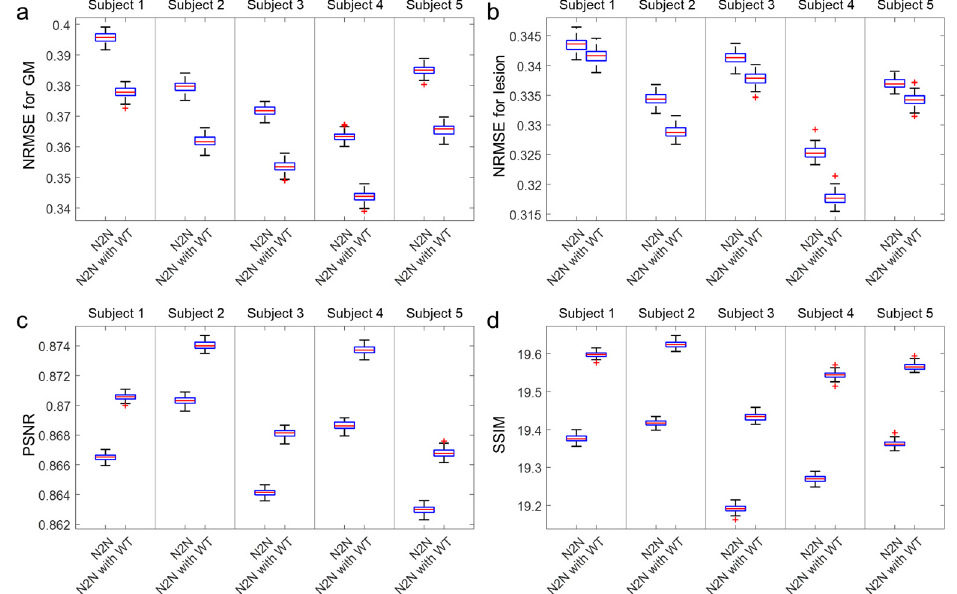
Figure 3. Results of the quantitative analysis for each test subject with 100 noisy realizations using Noise2Noise with and without wavelet transform. ( a ) NRMSE (normalized root-mean-square error) for gray matter, ( b ) NRMSE for random lesions, ( c ) PSNR (peak-to-signal ratio), and ( d ) SSIM (structural similarity metric).